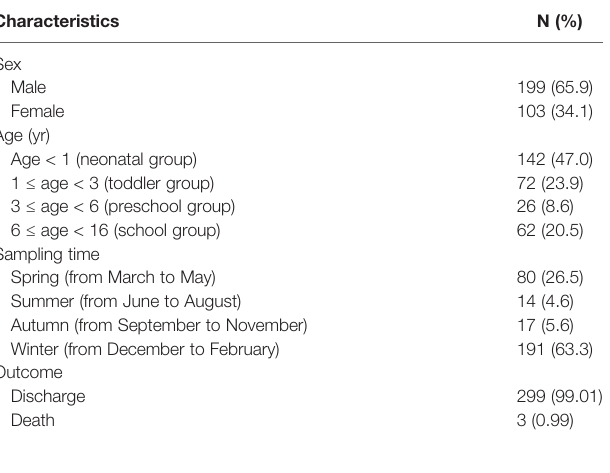
TABLE 1 | Characteristics of 302 included children.